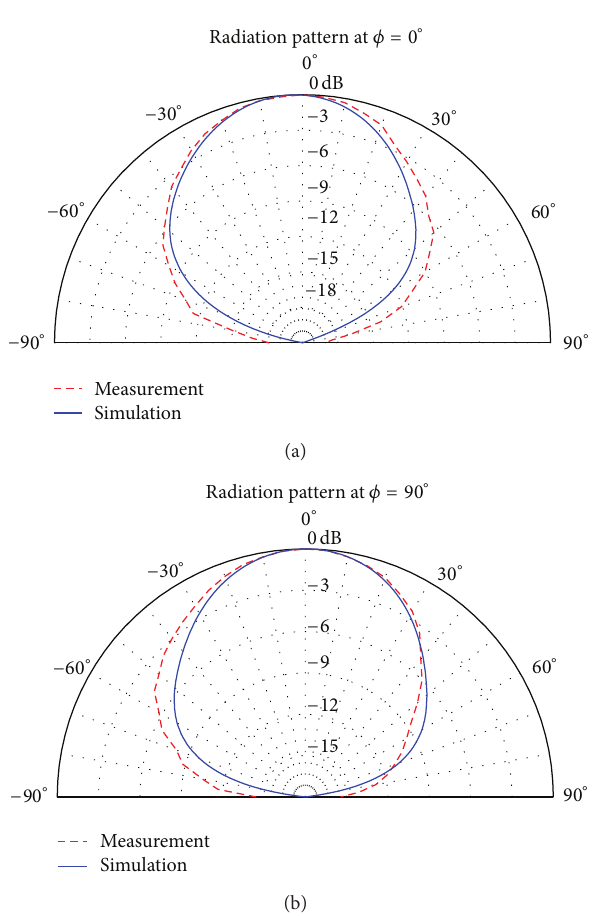
Figure 5: Simulated (solid line) and measured (dashed line) radiation patterns of spiral antenna at 434 MHz, for 𝜙 = 0 plane (a) and 𝜙 = 90 ∘ plane